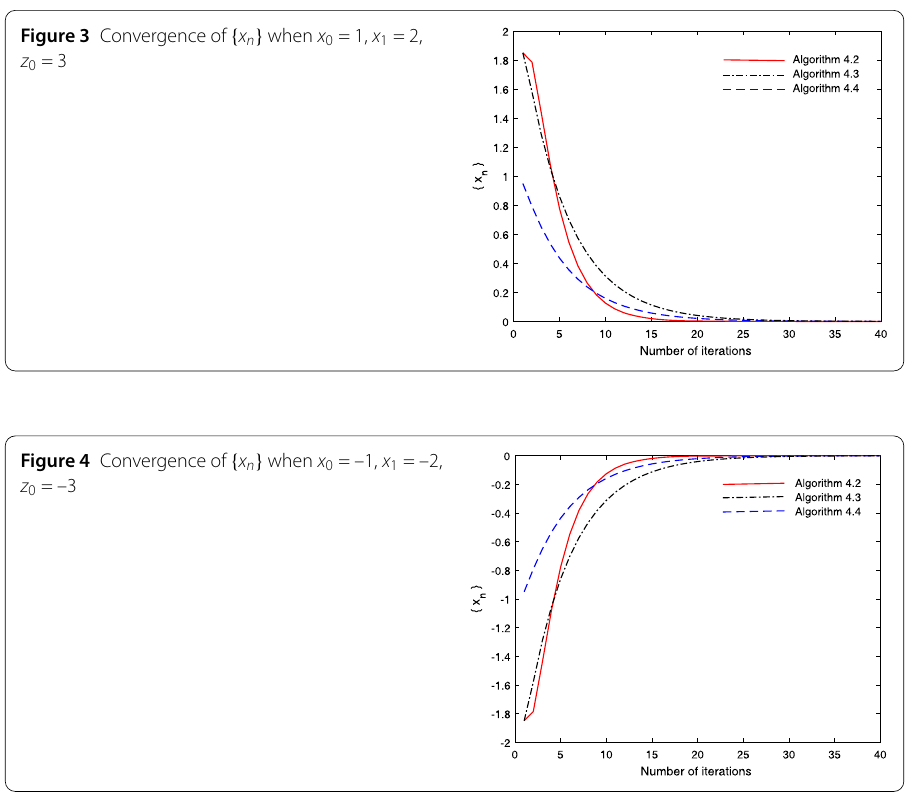
Figure 3 Convergence of { x n } when x 0 = 1, x 1 = 2, z